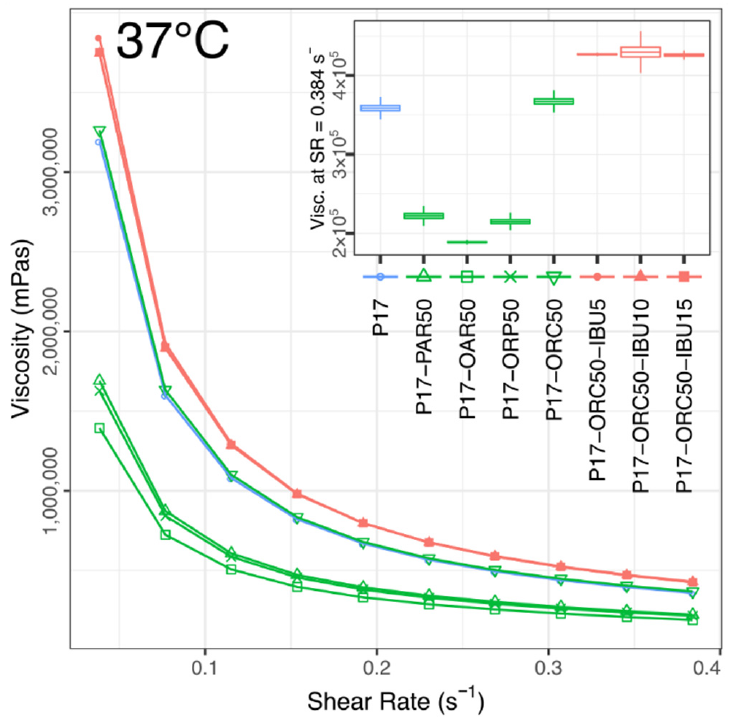
Figure 8. Viscosities vs. shear rate in all tested formulations. 37 °C, mean values, n = 3. Inset shows mean viscosities at SR = 0.0384 s − 1 (±std error, ±95% conf. interval).